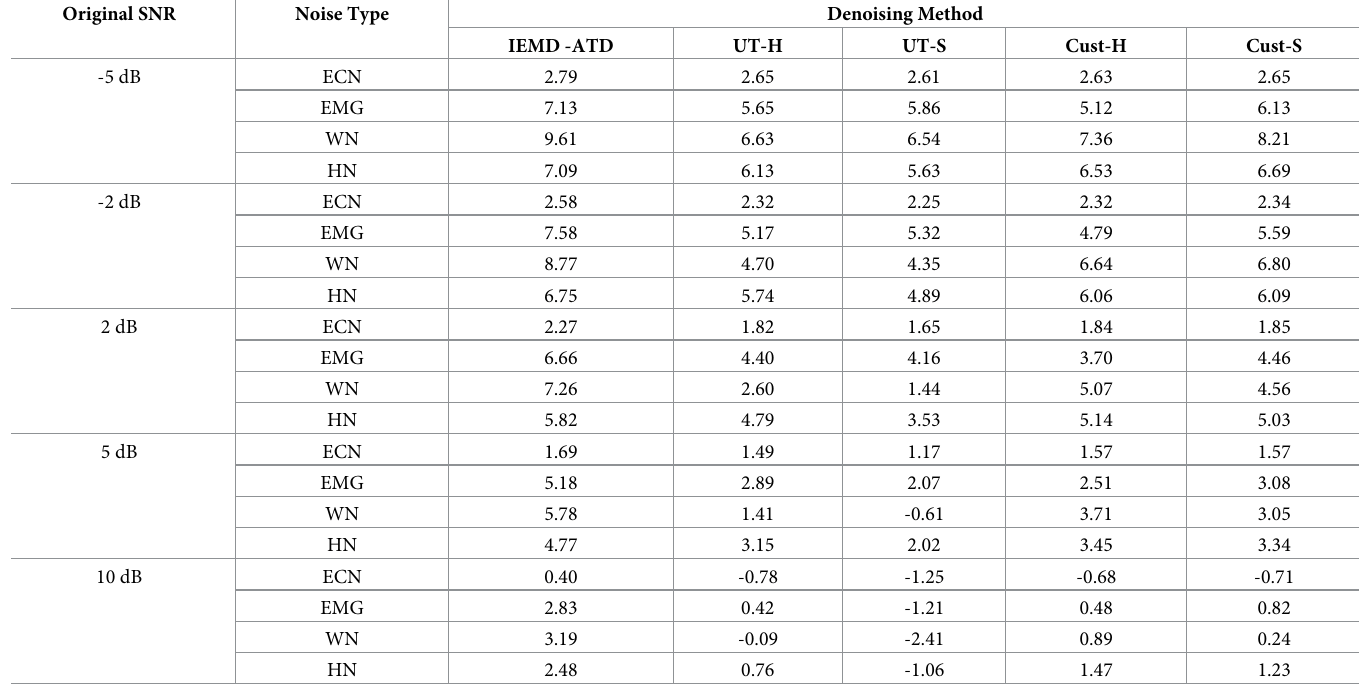
Table 12. Average SNR improvement of 10 real